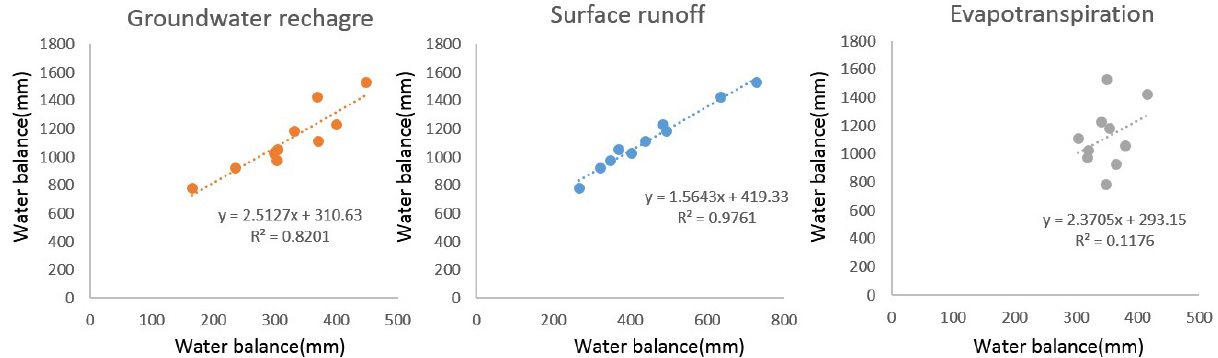
Figure 4. Relationship between precipitation and simulated evapotranspiration, surface runoff and groundwater recharge.